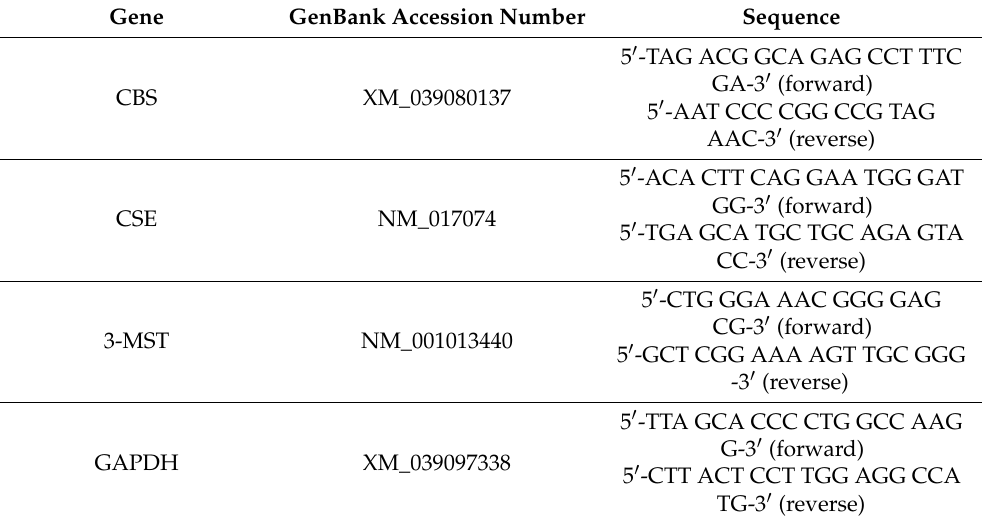
Table 1. List of primer sequences used for RT-qPCR.